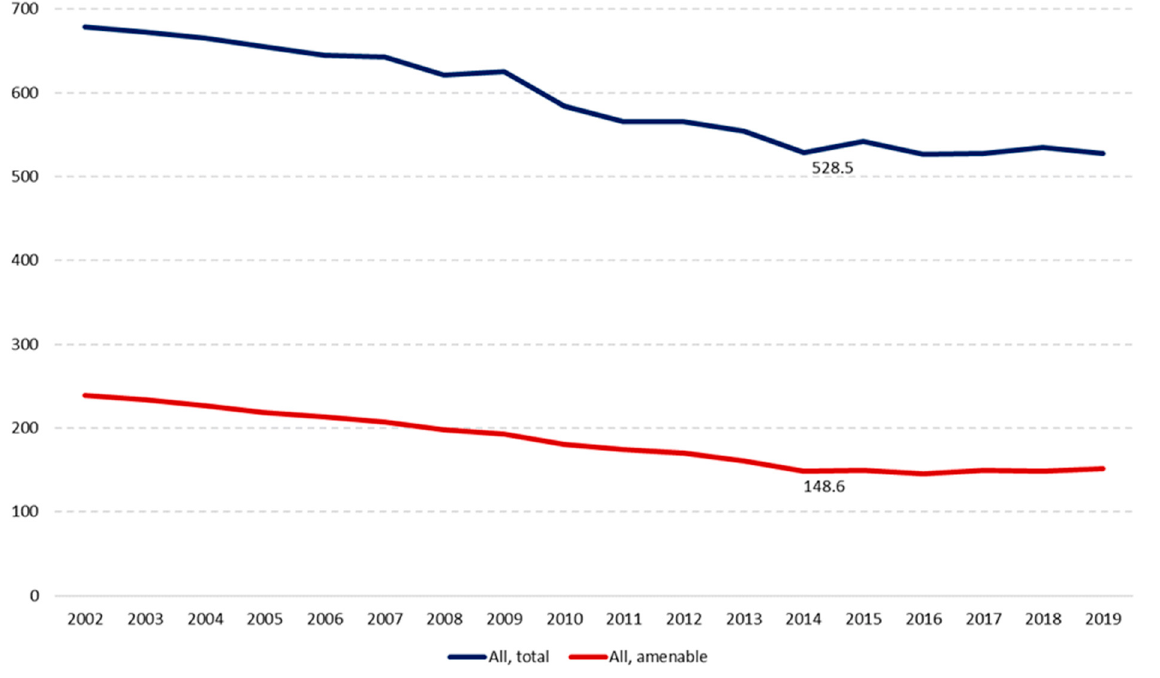
Figure 1. Trends in mortality in Poland, 2002–2019, age-standardised rate per 100,000 population.